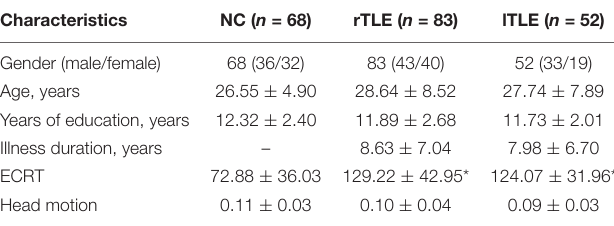
TABLE 1 | Characteristics of the